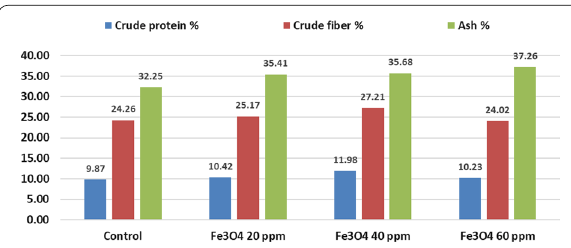
Fig. 4 Effect of foliar application with Fe 3 O 4 NPs on nutritional values of Moringa oleifera L (LSD 5%: crude protein 0.012 & = fiber 1.21 & Ash 1.87) = =